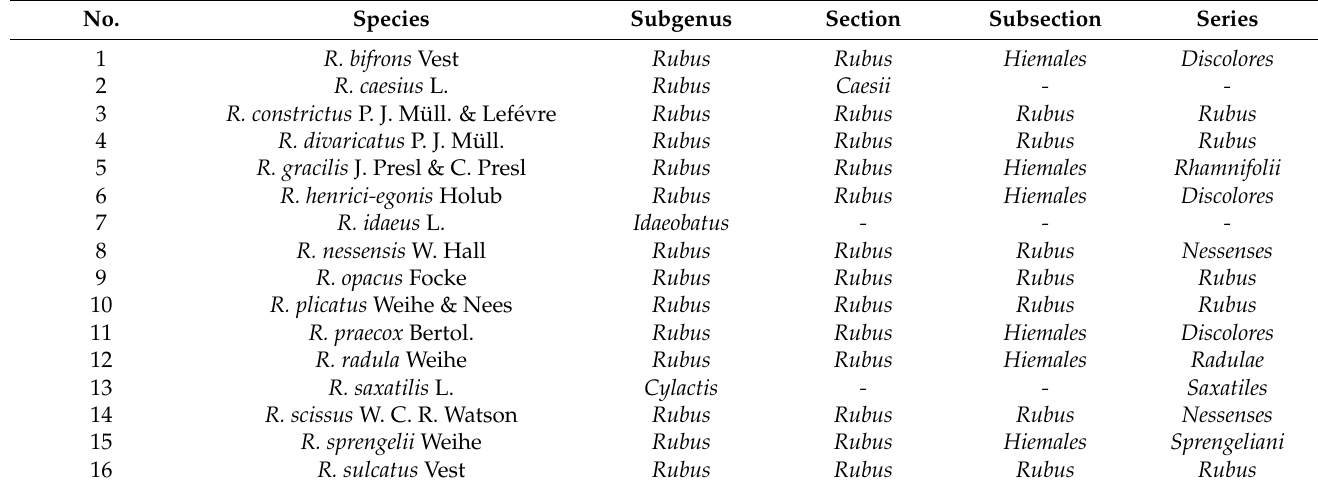
Table 1. The taxonomic classification of the Rubus species